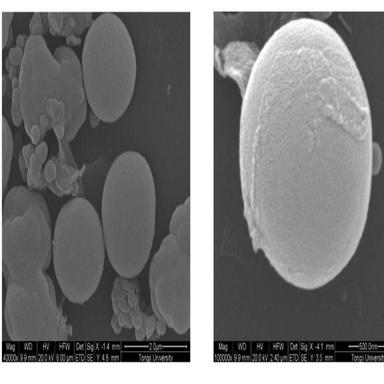
Morphology of silica microsphere (a), (b) without pore expansion and (c), (d) with pore expansion.